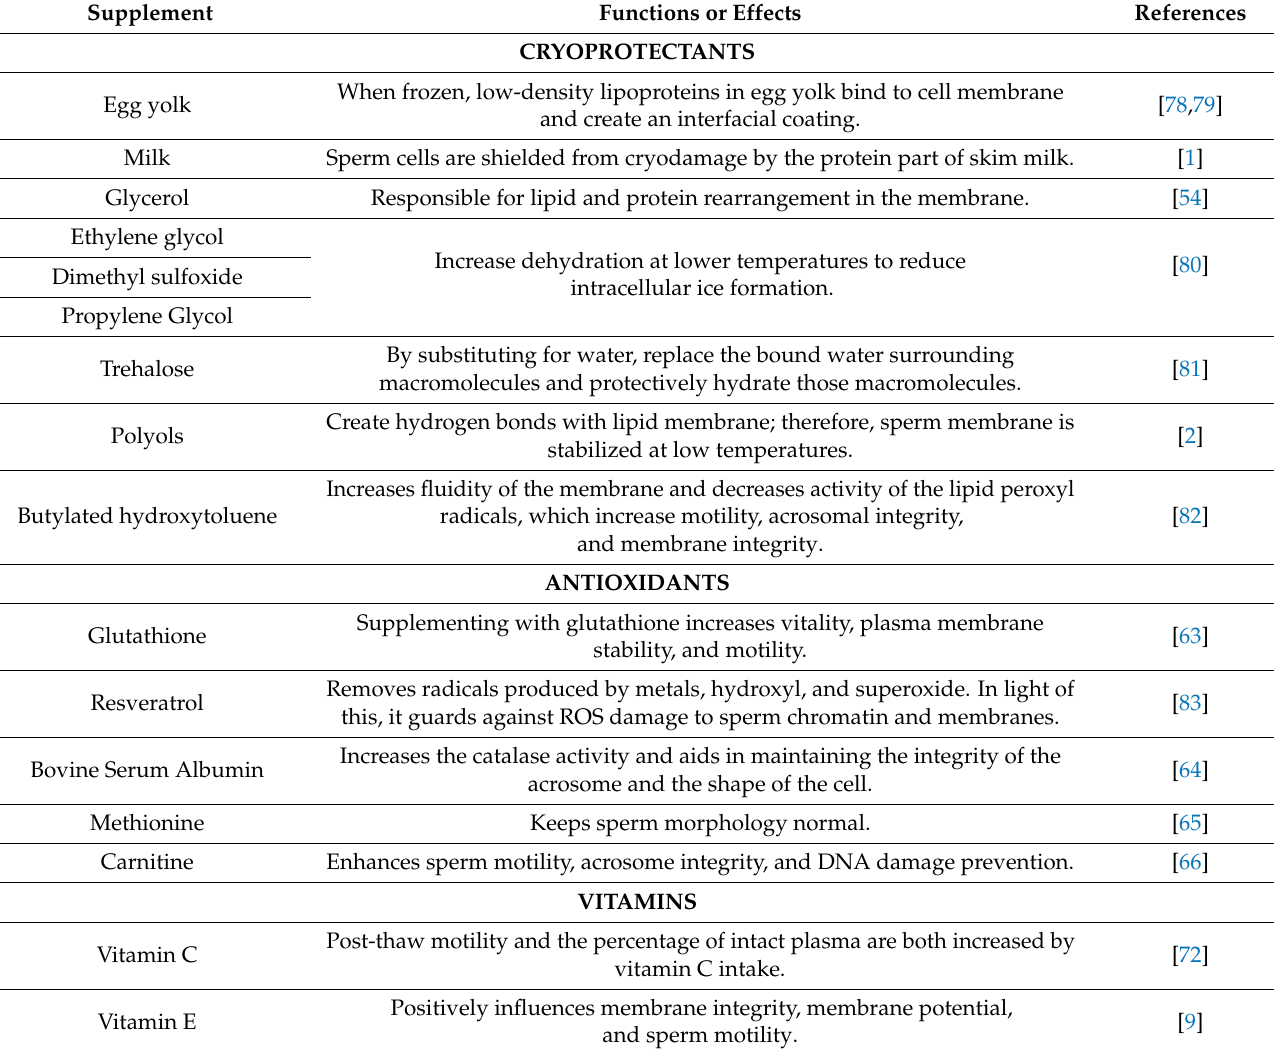
Table 2. Extender development for sperm cryopreservation (Ugur et al. [77]).